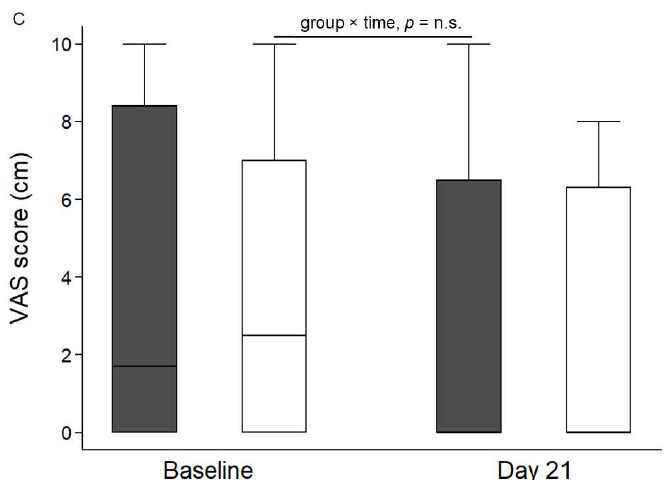
Figure 2. Visual analogue scale (VAS) score for gastrointestinal symptoms. VAS for abdominal pain ( A ), fecal consistency ( B ), and post-prandial fullness severity ( C ). In each plot, data is shown as median (line), inter-quartile range (box limits), and min/max (whiskers); R-GFD: regular gluten-free diet; LF-GFD: low-FODMAP gluten-free diet; n.s.: non-significant.